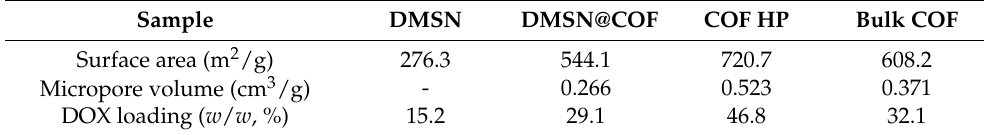
Table 1. The texture properties and DOX loading capacity of different materials.